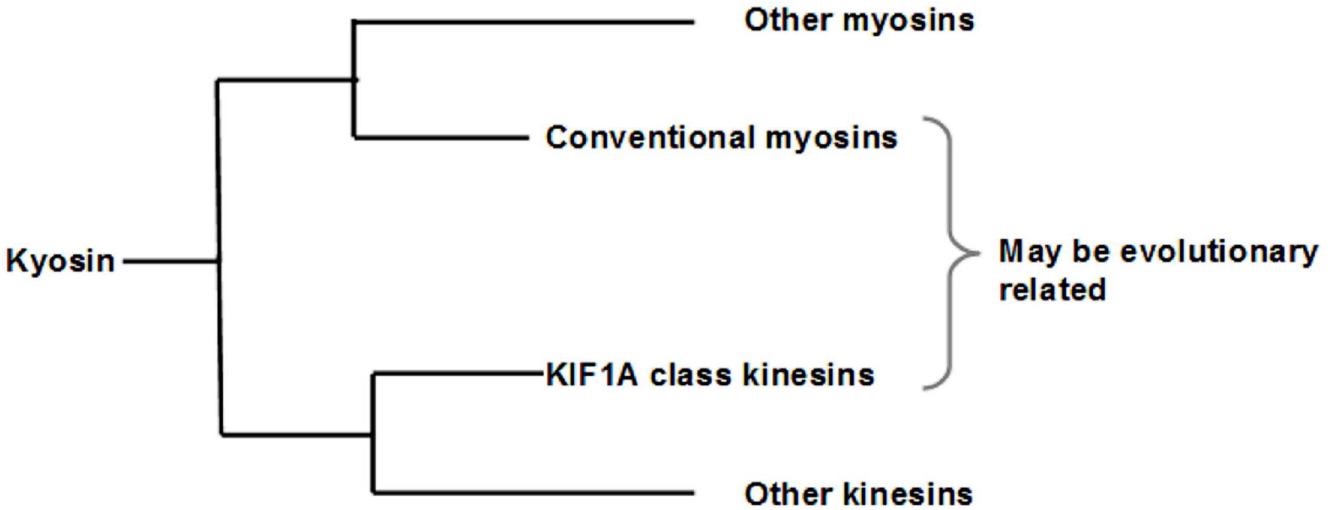
Fig 3. Proposed phylogenetic tree of KIF1A and Conventional